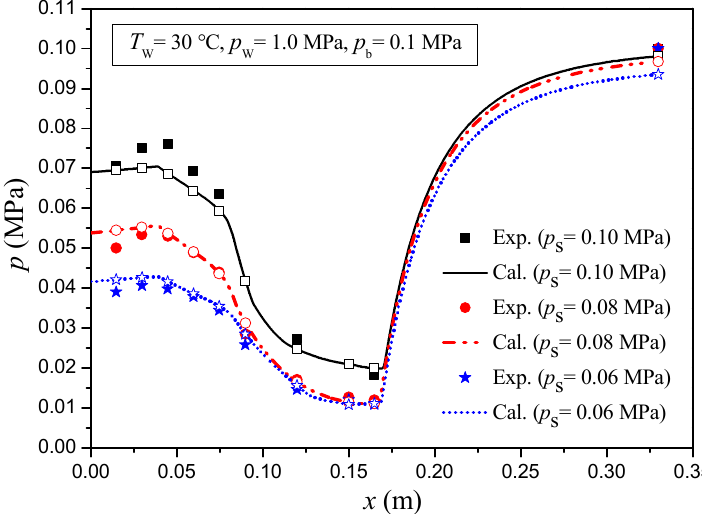
Figure 7. ϕ comparisons for different back pressures.